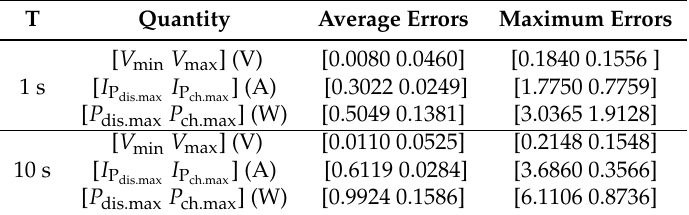
Table 3. The errors of maximum available power